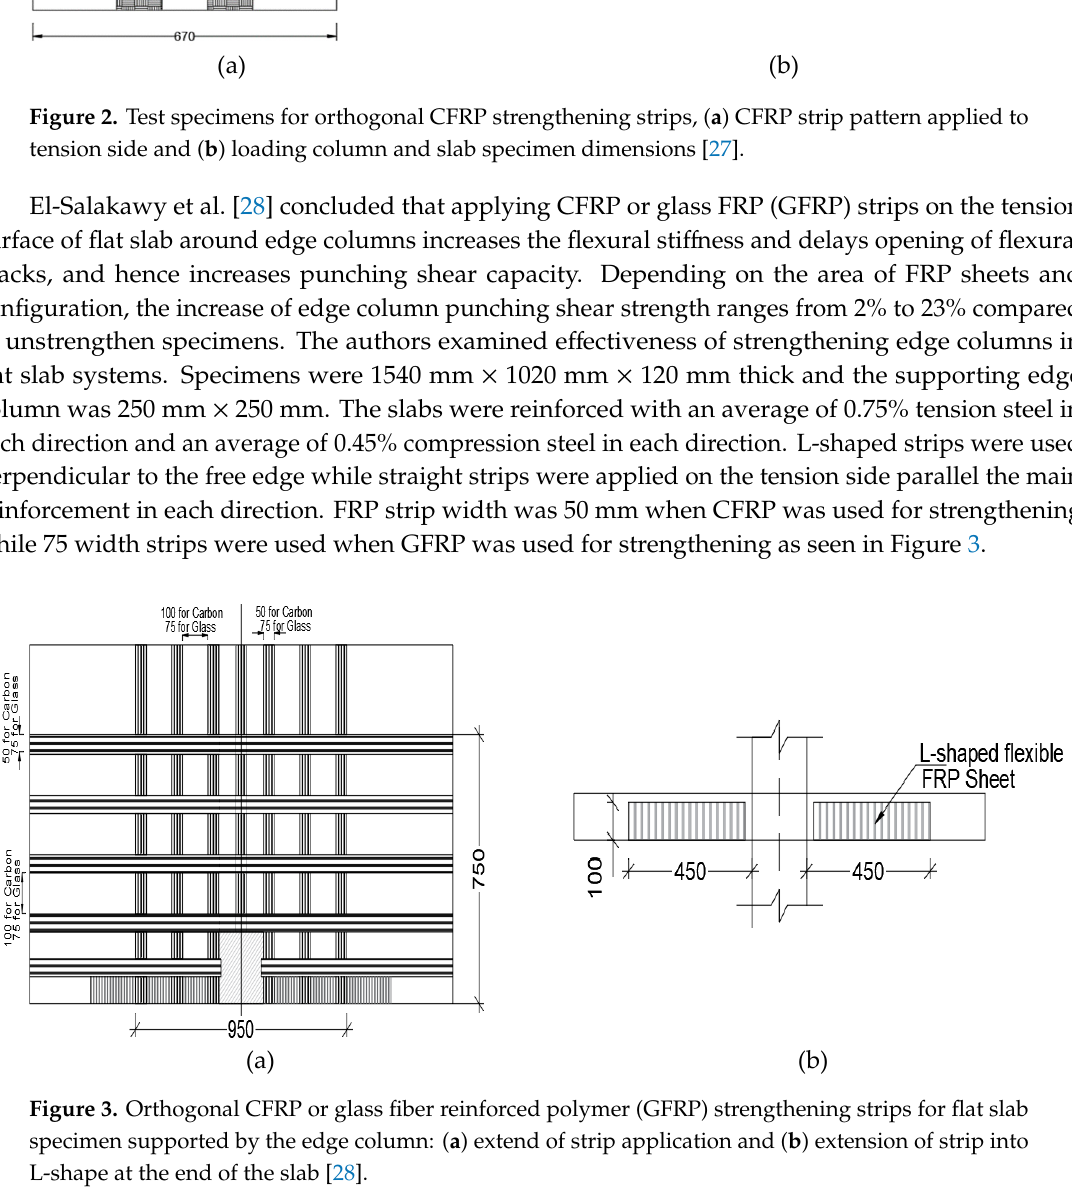
Figure 2. Test specimens for orthogonal CFRP strengthening strips, ( a ) CFRP strip pattern applied to tension side and ( b ) loading column and slab specimen dimensions [27].